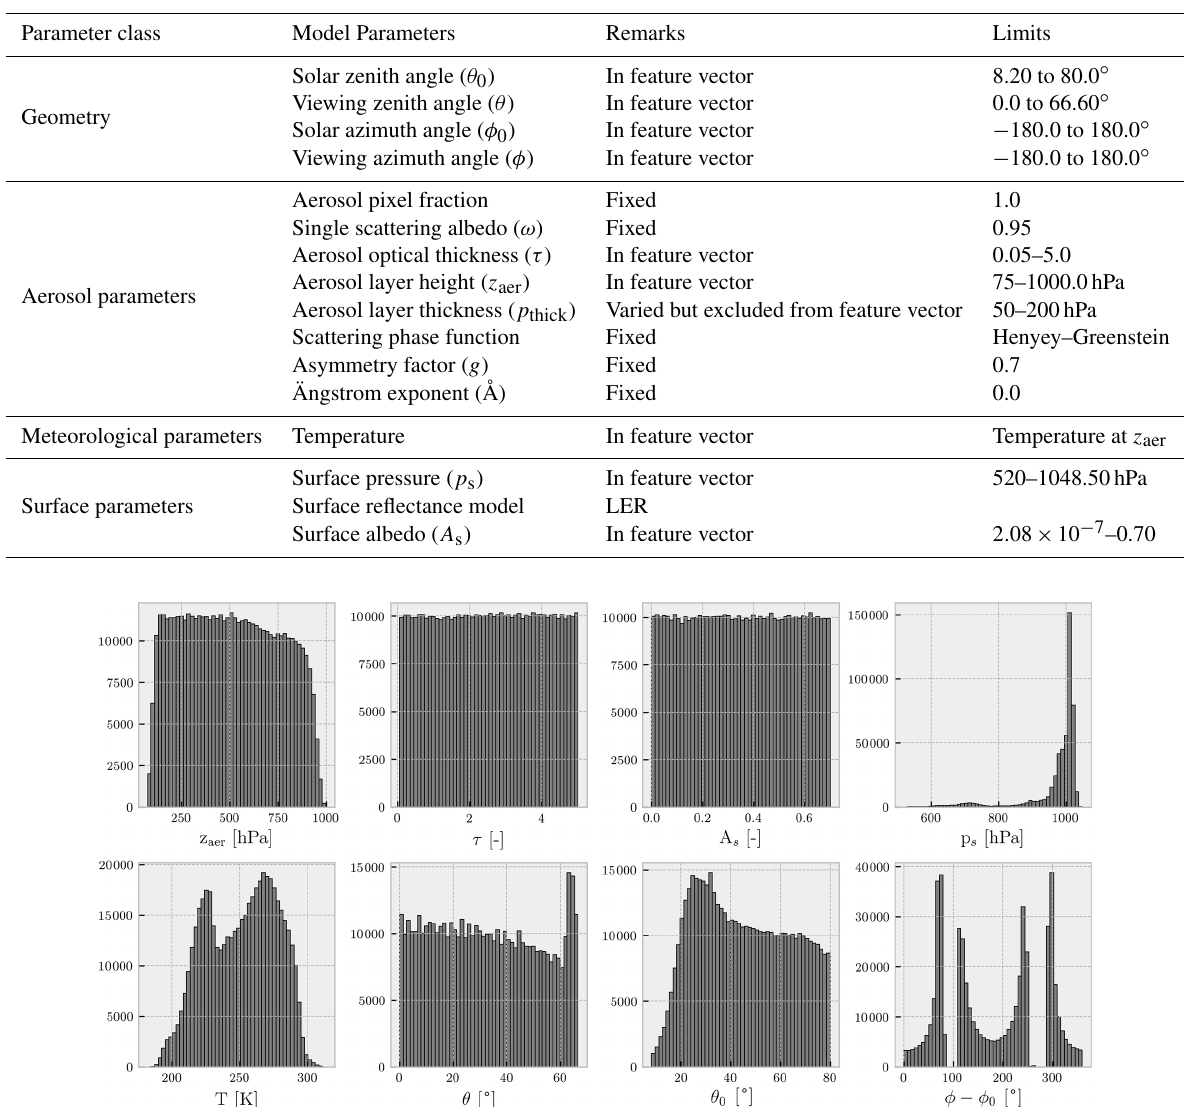
Table 2. Scene-dependent input model parameters for the NN model. See also Fig. 1 for a histogram of the input parameters. The solar– satellite geometry parameters are generated in combinations conforming to those encountered by TROPOMI’s orbits.